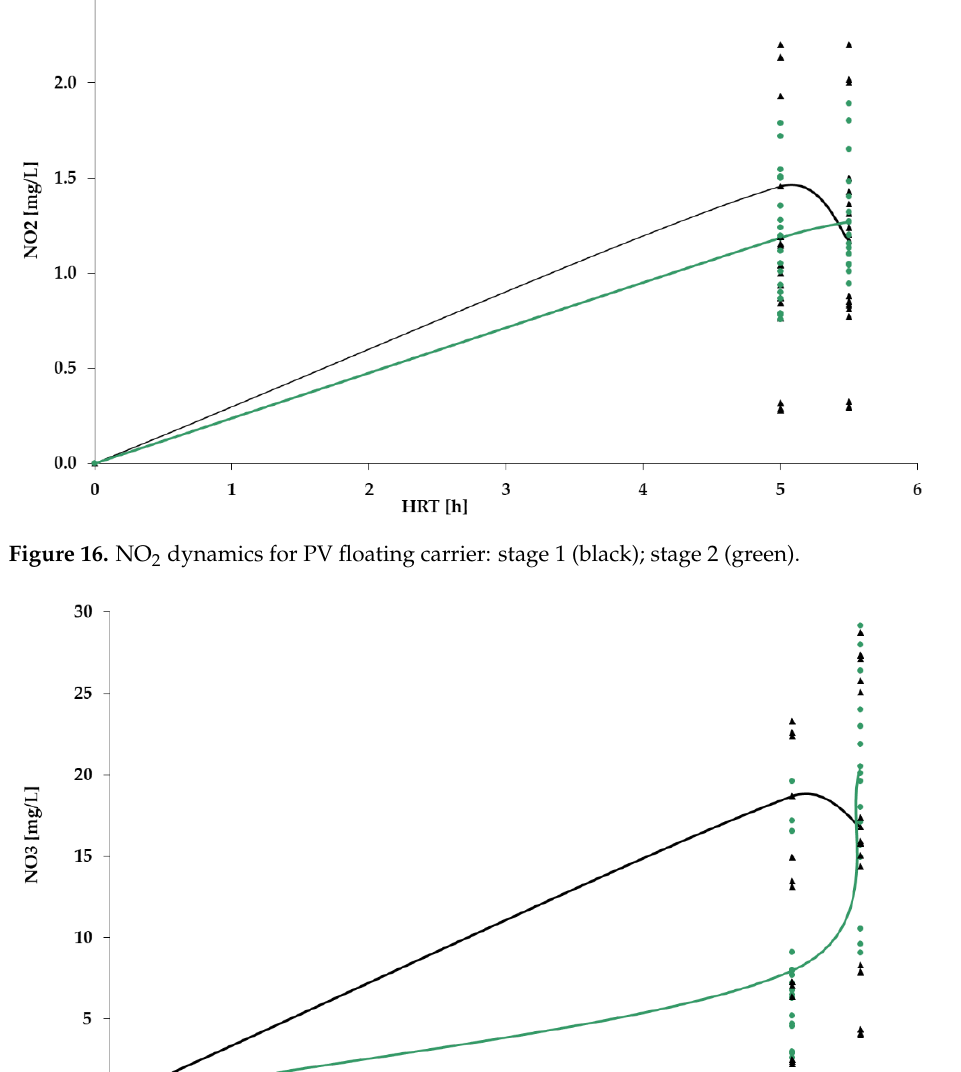
Figure 15. NH 4 removal dynamics for PV floating carrier: stage 1 (black); stage 2 (green).